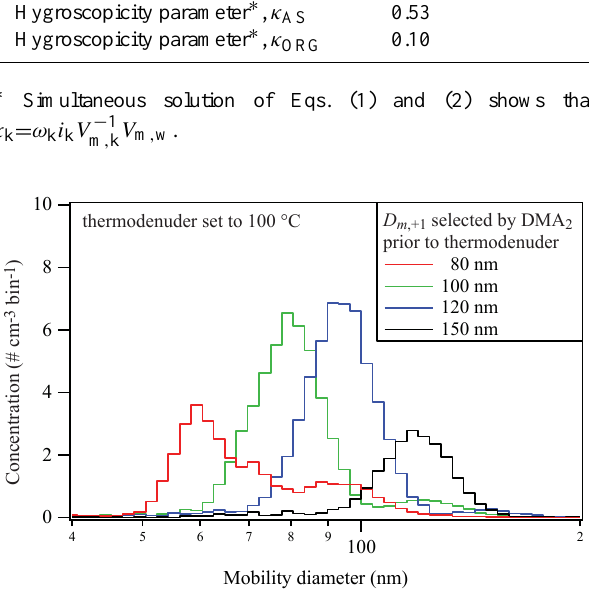
orate for the employed temperatures and residence times (Fig. S1: http://www.atmos-chem-phys.net/10/3953/2010/ acp-10-3953-2010-supplement.pdf ) (An et al., 2007; Huff- man et al., 2008). Figure 5 shows the residual organic vol- ume fraction for particles initially of 100 nm for increas- ing thermodenuder temperature (i.e., volatilization curves). and within uncertainty the volatilization curves are the same, indicating little to no dependence on the extent of evapo- ration for the different C 5 H 8 :NO x ratios among the experi- ments. The results at 100 ◦ C agree with those of Poulain et al. (2009), who also observed that 65% of the organic particle mass concentration formed from α -pinene ozonolysis evap- orated at 100 ◦ C. Fierz et al. (2007) emphasized the impor- tance of the effects of thermodenuder residence time, and we therefore carried out experiments both for flow rates of 2.5 and 1 Lpm, corresponding to residence times of 0.7 and 1.8 s, respectively. Similar volatilization curves were obtained for both flow rates. No particle mass spectra were collected after the thermodenuder. curves were collected for in- creasing thermodenuder temperature (Fig. S2: http://www.atmos-chem-phys.net/10/3953/2010/ acp-10-3953-2010-supplement.pdf). The shift in number- diameter distribution to smaller particles for increasing thermodenuder treatment (cf. Fig. 4) is expected to